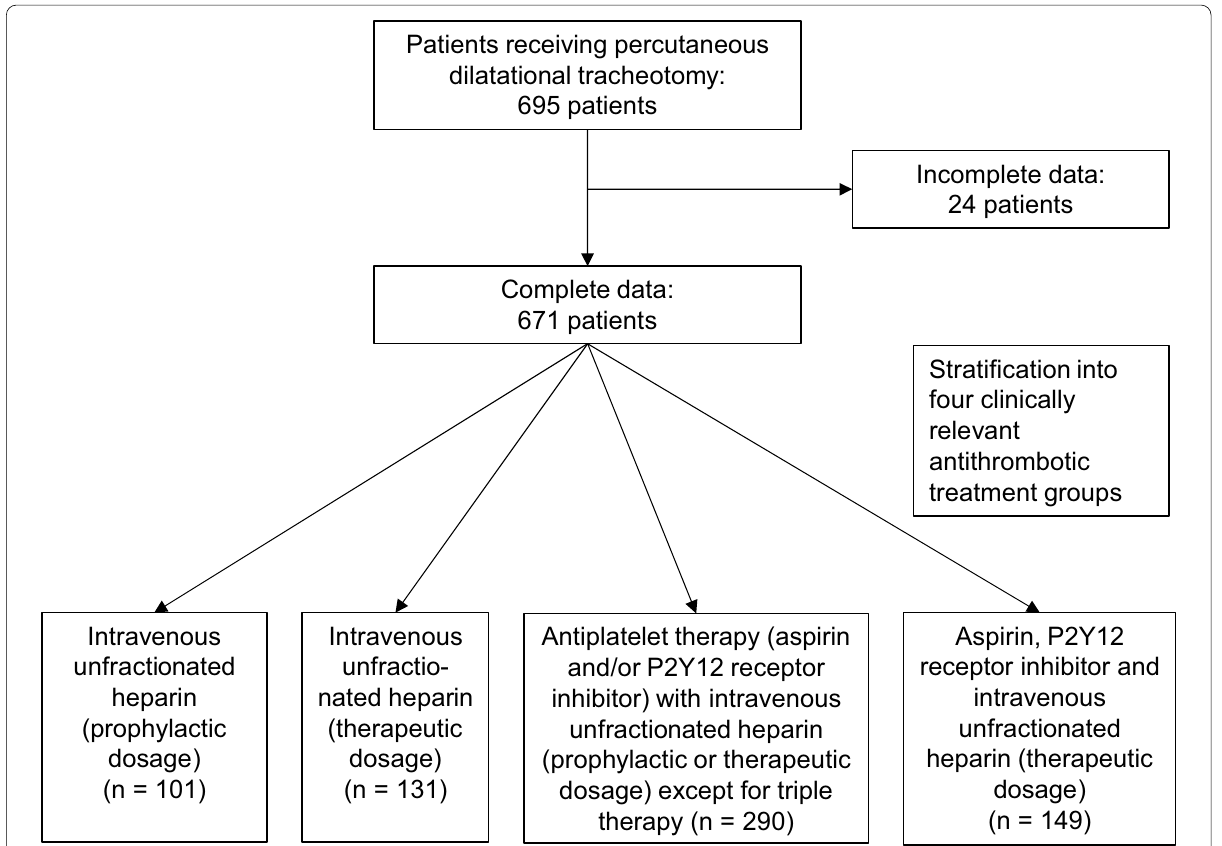
Fig. 1 Study flowchart. Flow diagram depicting patient